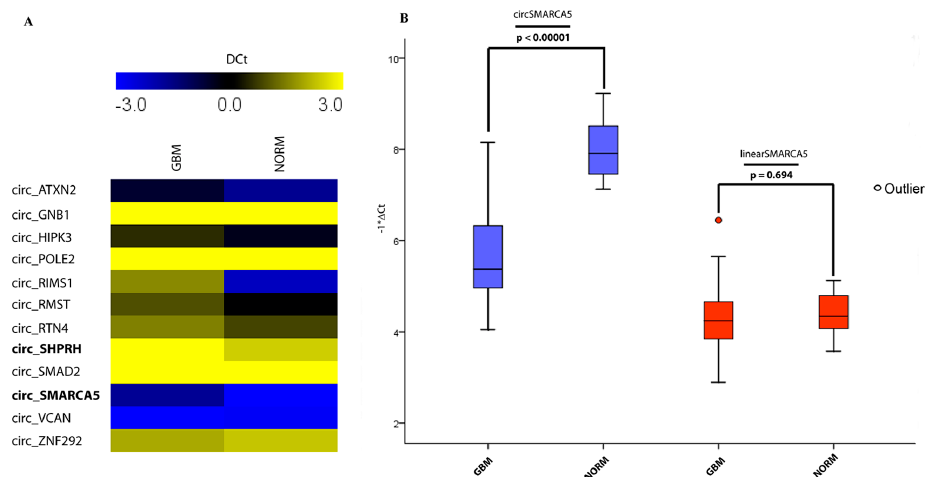
Figure 1. Expression of candidate circRNAs in GBM and control (NORM) samples. ( A ) Heat map representing the expression profile of twelve candidate circRNAs in GBM and control samples. Expression values (reported as DCt) higher and lower than those of the control are shown in yellow and blue, respectively. circSHPRH and circSMARCA5 are in bold, due to their significant downregulation ( p -value circSHPRH = 0.015, p -value circSMARCA5 = 0.017, n = 5, Student’s t -test). ( B ) Box-plots representing the expression of circSMARCA5 and linearSMARCA5 in GBM and control samples. Expression values are reported as − DCt relative to (mRNA) TBP ( p -values are shown in the figure, n GBM = 56, n NORM = 7, Student’s t -test).